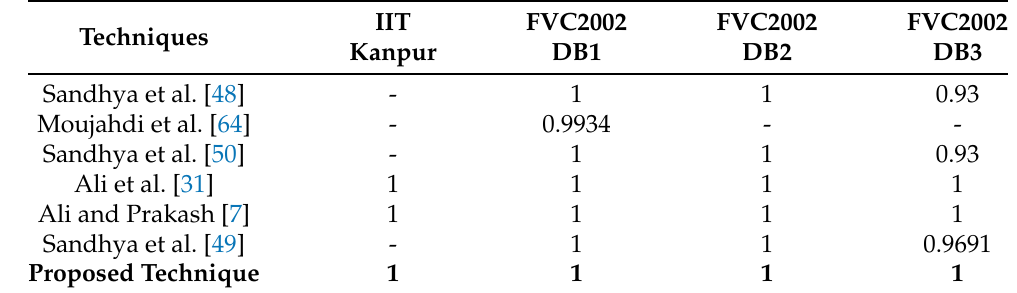
Figure 10. Kolmogorov–Smirnov (KS) test graph for the proposed technique and the other techniques, signifying a good separation between the imposter and genuine scores for the proposed technique. Table 5. KS test values